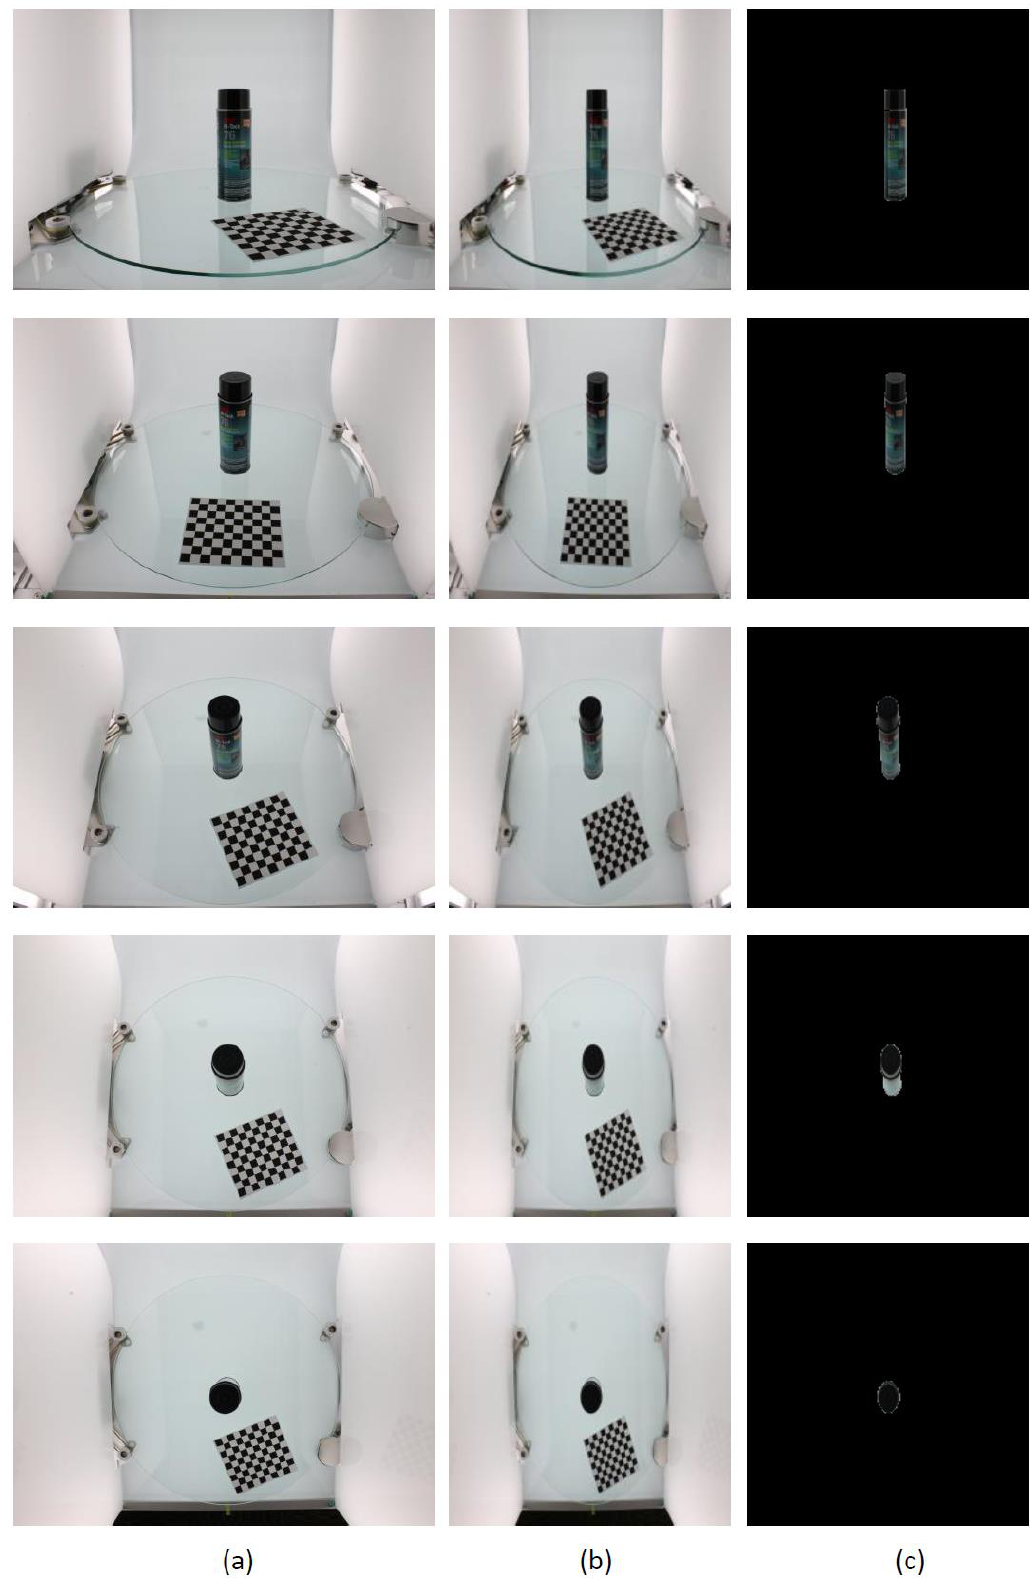
Figure 9. GrabCut-based segmentation experiment results for 3 m_high_tack_spray_adhesive object: ( a ) original input image; ( b ) image after resizing; ( c ) GrabCut method segmentation